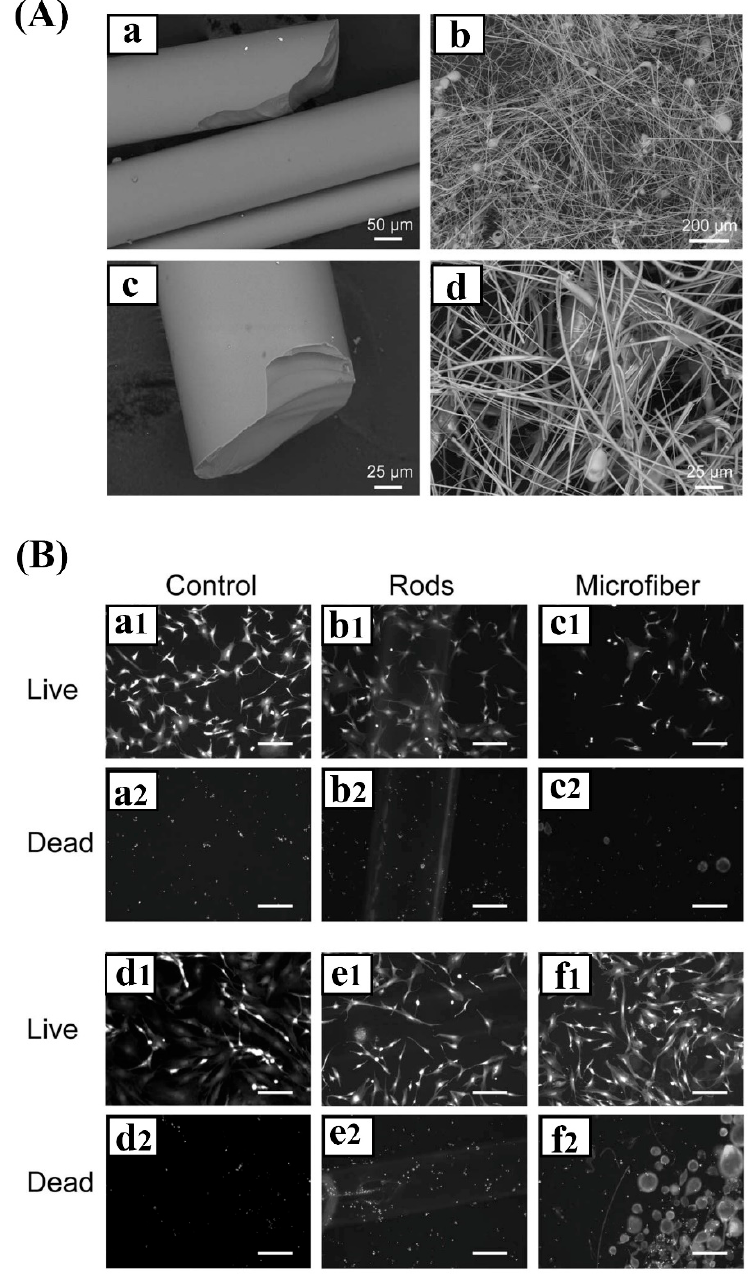
Figure 7. ( A ) SEM micrographs of melt-derived 13-93 B3 borate BGs in rod (a,c) and microfiber (b,d) forms. ( B ) Microscopic images of embryonic chick dorsal root ganglia (DRG) cells alone (control groups a1 / a2 and d1 / d2) or treated with 13-93 B3 rods (b1 / b2 and e1 / e2) and microfibers (c1 / c2 and f1 / f2). Note that the images were captured from the cells after 6 days of culture. The culture medium was exchanged every other day (transient condition) in the two top rows, while no medium was exchanged throughout the experiment (static condition) in the two bottom rows. Scale bar is 100 µm. Reproduced with some modifications from ref [23].